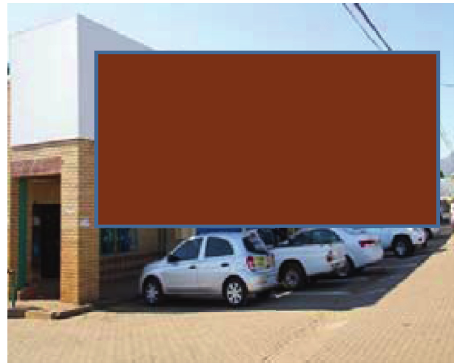
Figure 3: Cashbuild: site